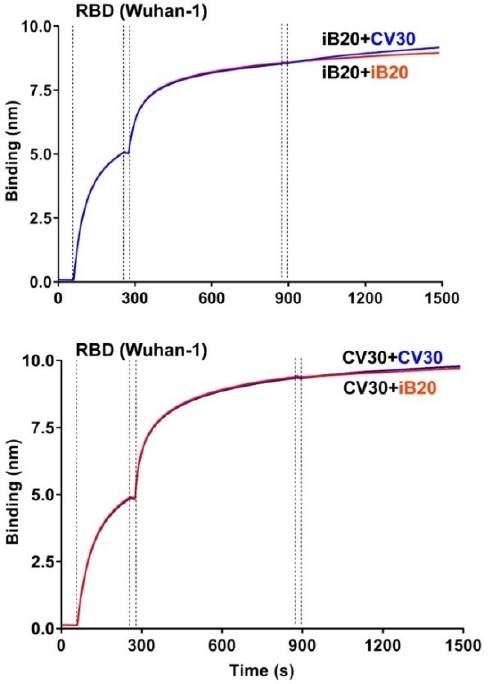
Figure 3. Competition BLI assay for iB20 and CV30 binding to SARS ‐ CoV ‐ 2 RBD.